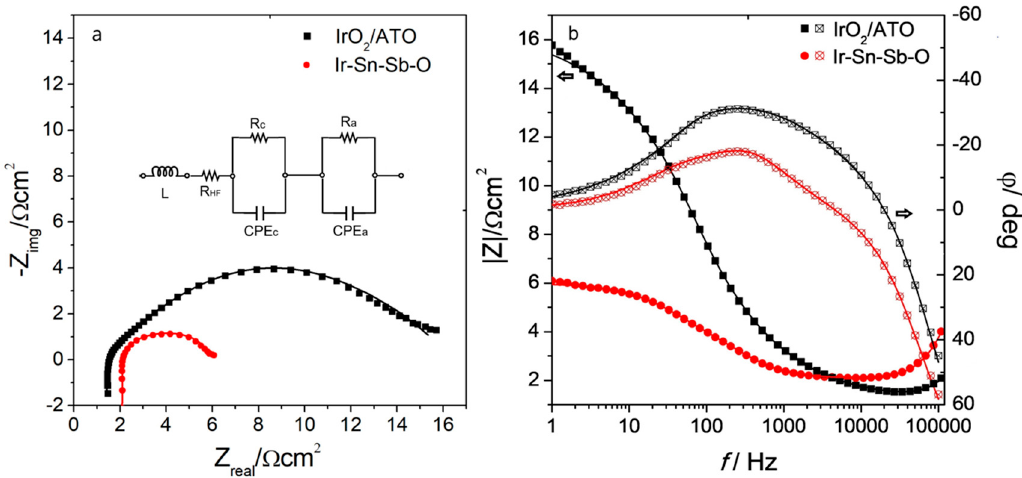
Figure 8. Electrochemical impedance spectroscopy (EIS) curves of IrO 2 /ATO ( ∎ ) and Ir-Sn-Sb-O ( ● ), ( a ) Nyquist plot, insert: proposed equivalent circuit. ( b ) Bode plots. The continuous lines depict the complex nonlinear least squares (CNLS) simulation curves from the equivalent circuit. The spectra were obtained at 1.6 V, 70 °C and a water flux of 7 mL min − 1 . Table 3. Equivalent circuit parameters obtained from CNLS fitting.